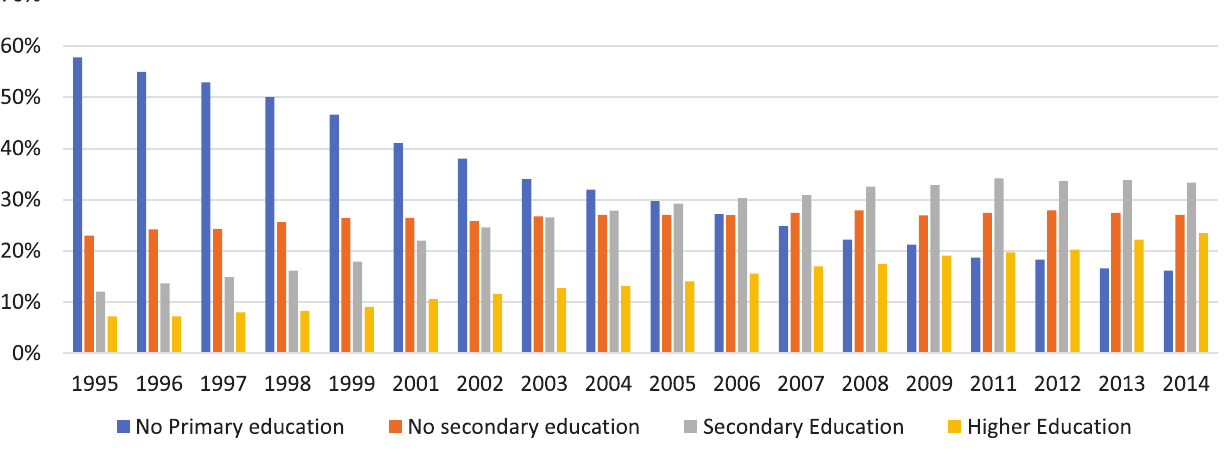
Figure 1. Brazil: Evolution of access to education from 1995 up to 2014, population with 18 up to 24 years old. Source: IBGE, n.d.-a). Tabulation done by the